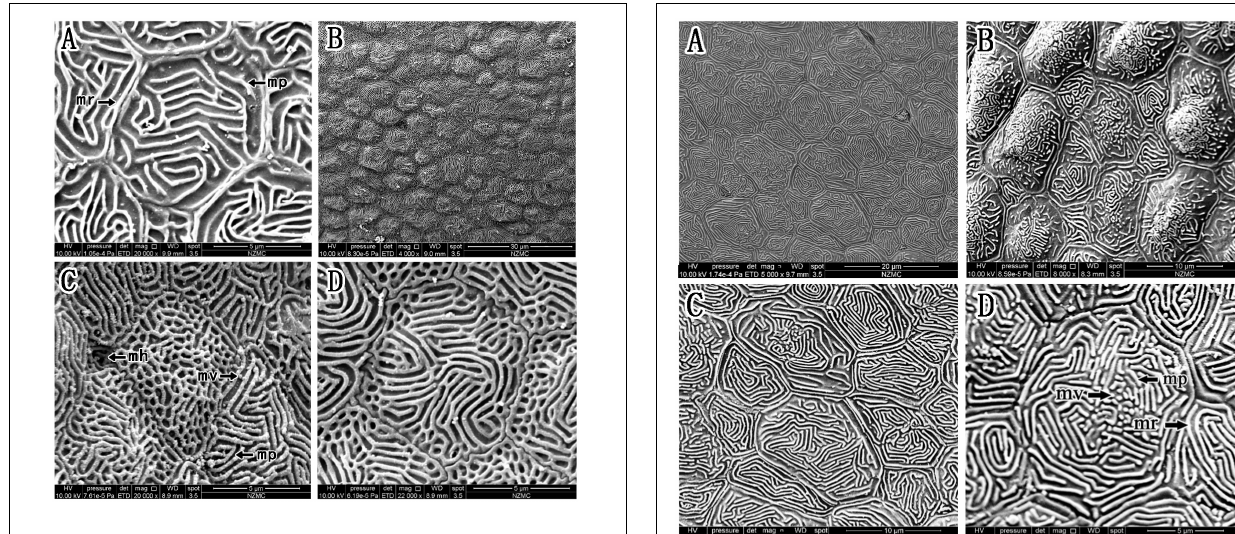
FIGURE 4 | (A–D) Corneal epithelial cells of B. pectinirostris under a scanning electron microscope. The types and microstructures of the epithelial cells are shown (mp, microplicae; mv, microvilli; mh, microholes; mr, microridges).